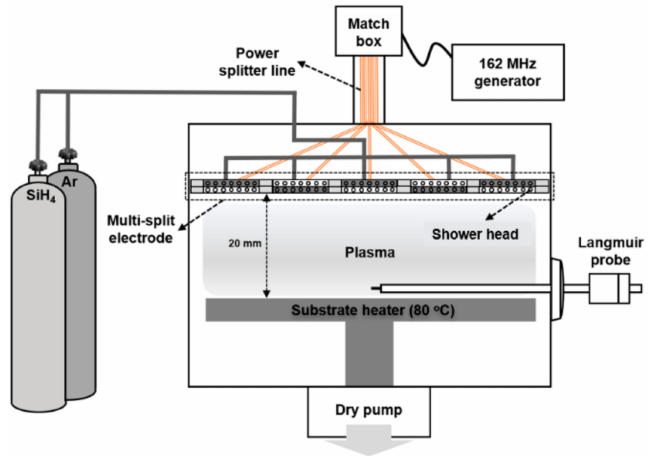
Figure 1. Schematic diagram of the VHF (162 MHz) plasma system with multi-split